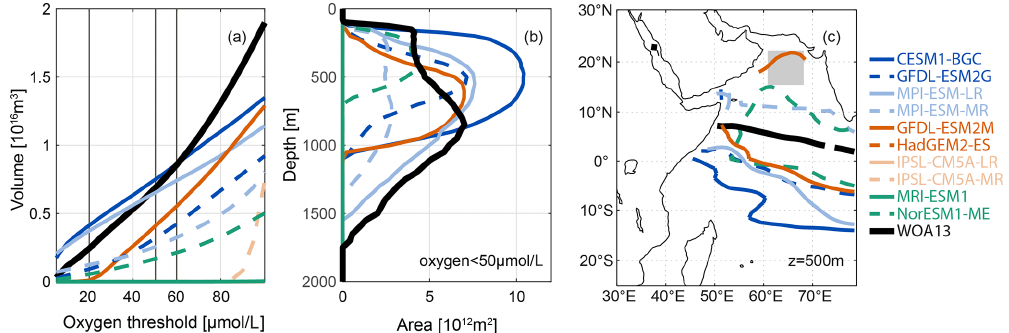
Figure 1. Comparison of the Arabian Sea OMZ in observations (WOA13, black) and the CMIP5 models (coloured): (a) OMZ volume for different oxygen thresholds. The vertical grey lines mark the 50µmolL − 1 threshold for (b) and (c) , as well as the 20 and 60µmolL − 1 thresholds that are discussed in the text. (b) Area of the OMZ for a threshold of 50µmolL − 1 at each depth. (c) Map of the OMZ area as defined in (b) at 500m of depth. The grey box marks the area of the averaged vertical profiles shown in Fig. 5. Different colours refer to the different model clusters (see